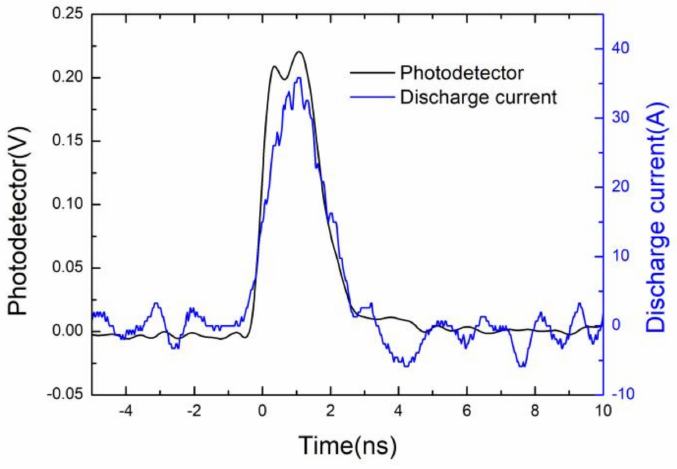
Figure 14. Variation of laser pulse peak power and pulse width at different pulses per second